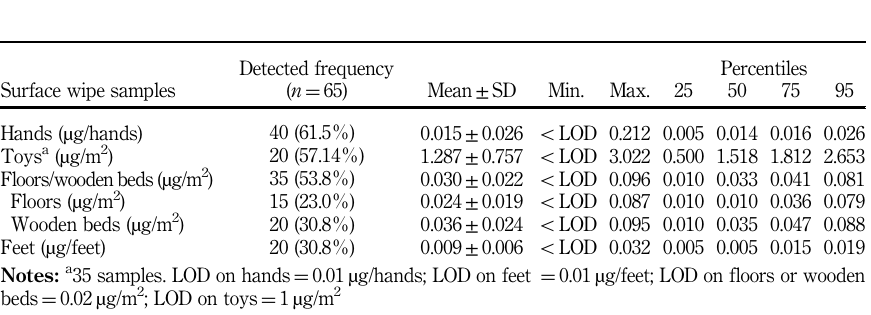
Table III. Chlorpyrifos residue concentrations